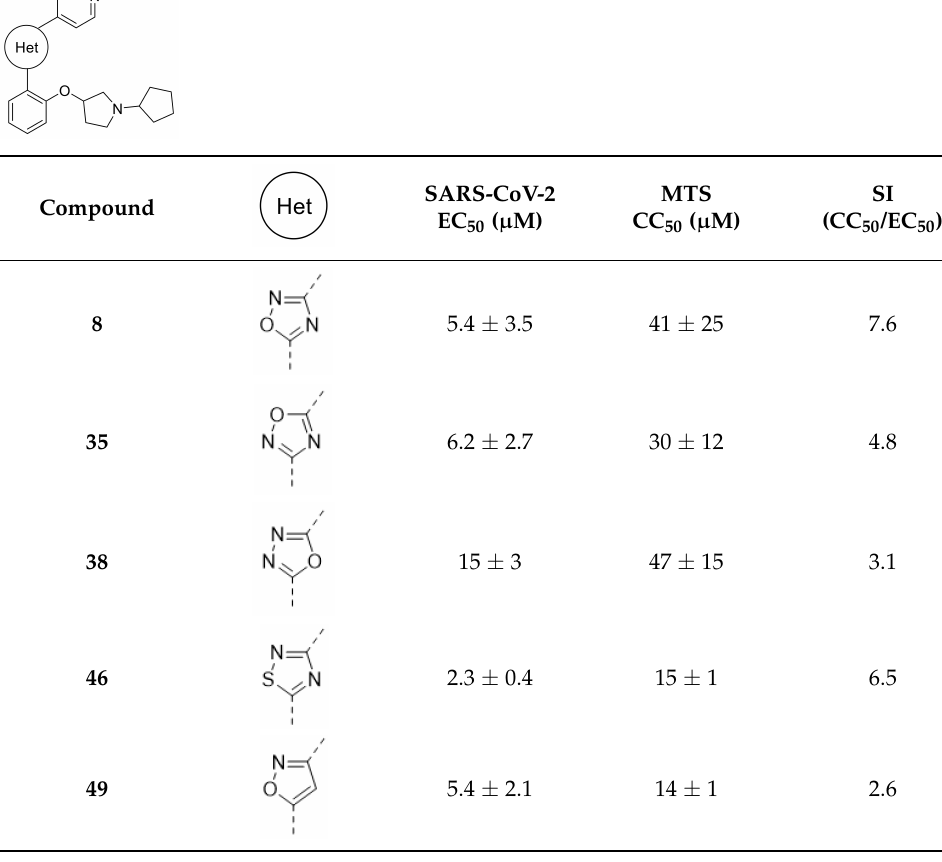
Table 4. Antiviral activity and cytotoxicity of compounds 8 , 35 , 38 , 46 , and 49 .